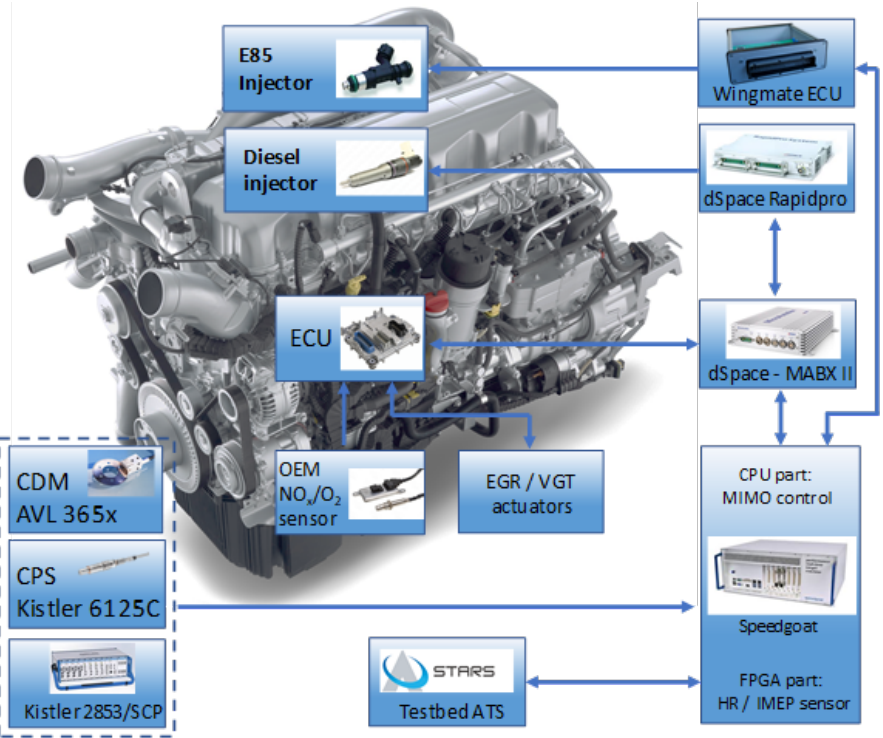
Figure 2. Overview of the hardware architecture of the implemented RCCI engine control system. Reprinted from [15] with permission. ©SAE International 2019.